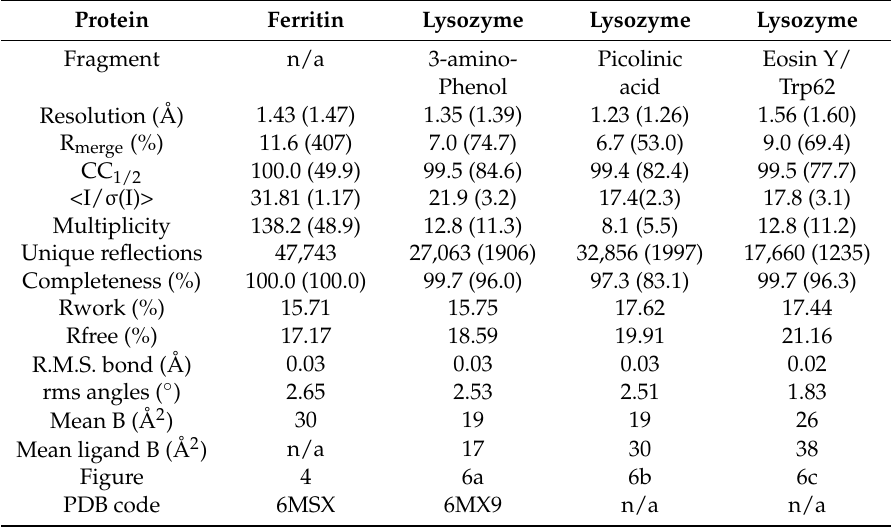
Figure 4. High quality crystals grown in 12 h yield accurate electron density for ferritin. Electron density is contoured at 3 σ (2fo–fc). Three residues are shown, the remainder of the ferritin is represented as a helix ribbon (6MSX). Table 2. Data reduction and structure refinement statistics.